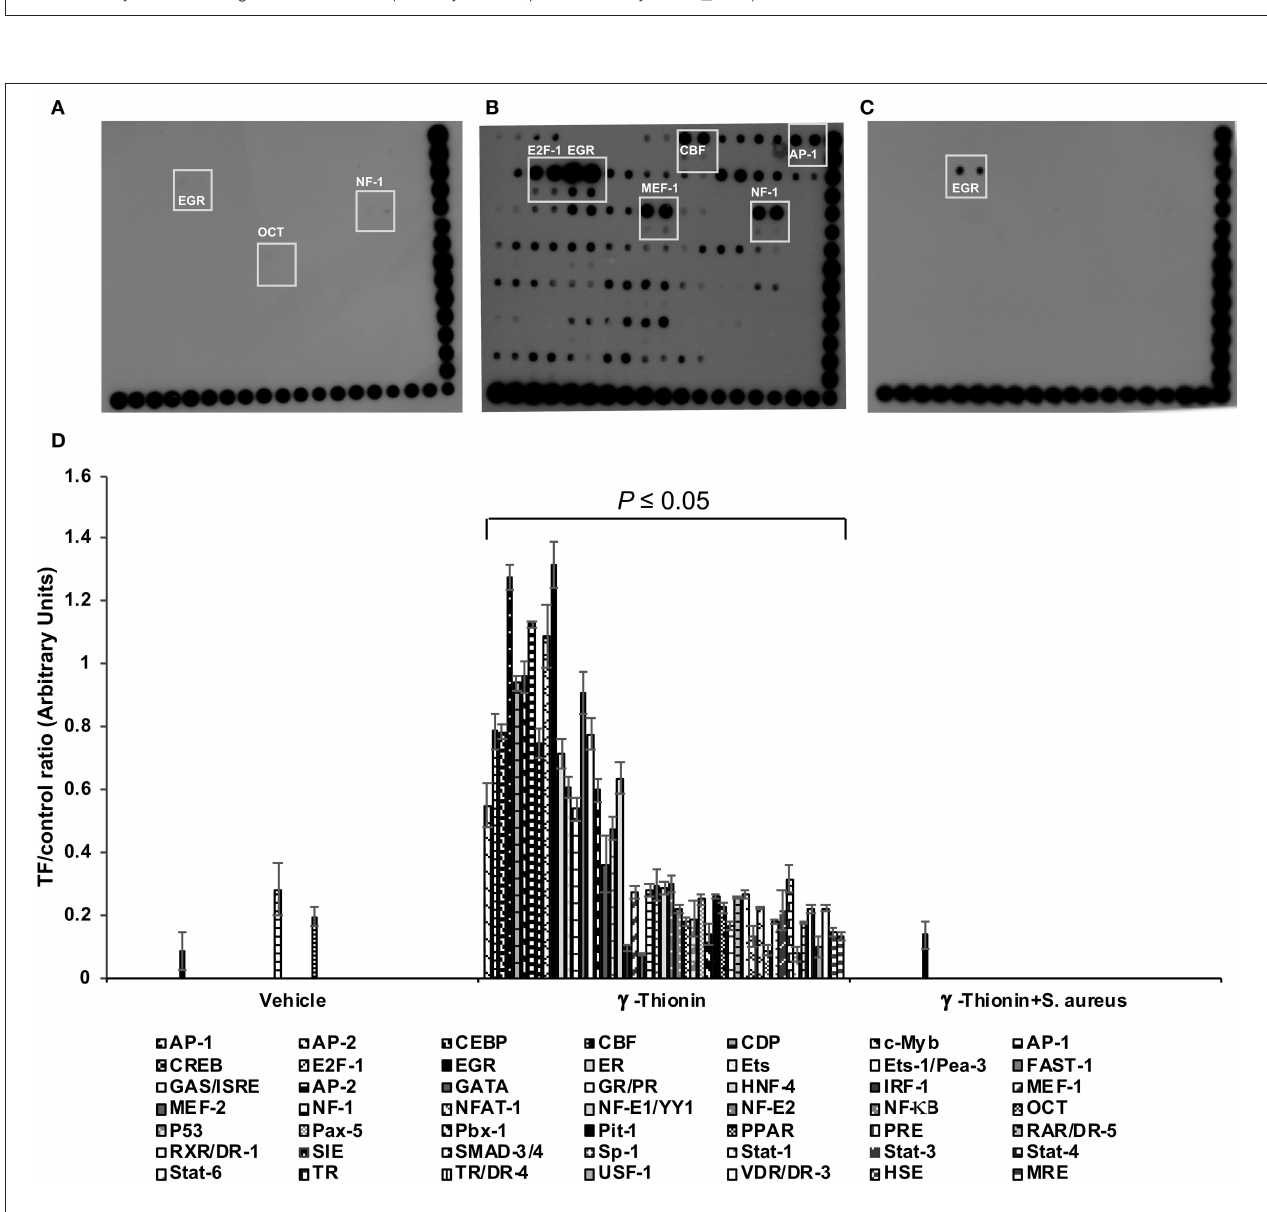
FIGURE 2 | (arbitrary units, AU) considering the expression of control cells (vehicle, DMSO 0.02%) as 1 (data normalized), from three different experiments ( n = 3). (C) The relative fluorescence intensities of AKT activation (phospho-AKT) in bMECs treated with γ -thionin (100ng/ml) and infected with S. aureus are shown. Fluorescence intensity was estimated from 10,000 events. An inserted histogram plot that shows AKT staining data in γ -thionin-treated bMECs (black line) and cells treated with the peptide that were challenged with S. aureus (red line). Each bar shows the mean of fluorescence of 10,000 events ± SD , considering the fluorescence of control bMECs as 1 (data normalized). Data were obtained from two different experiments, which were run in triplicate ( n = 6). Different letters between each condition analyzed indicate significant differences (one-way ANOVA, post-hoc Tukey test P ≤ 0.05) within the treatments. Vehicle was DMSO 0.02%.